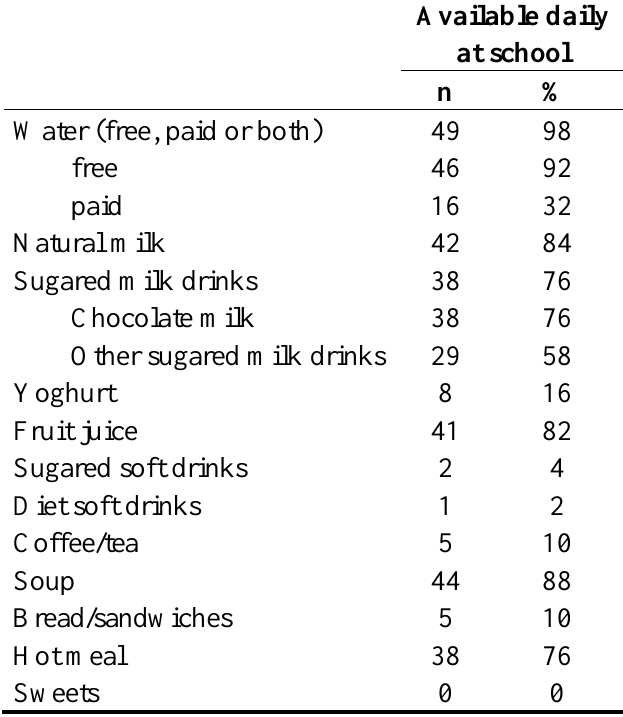
Table 1. Availability of food and beverages at nursery schools in East- and West-Flanders, anno 2008 (n =